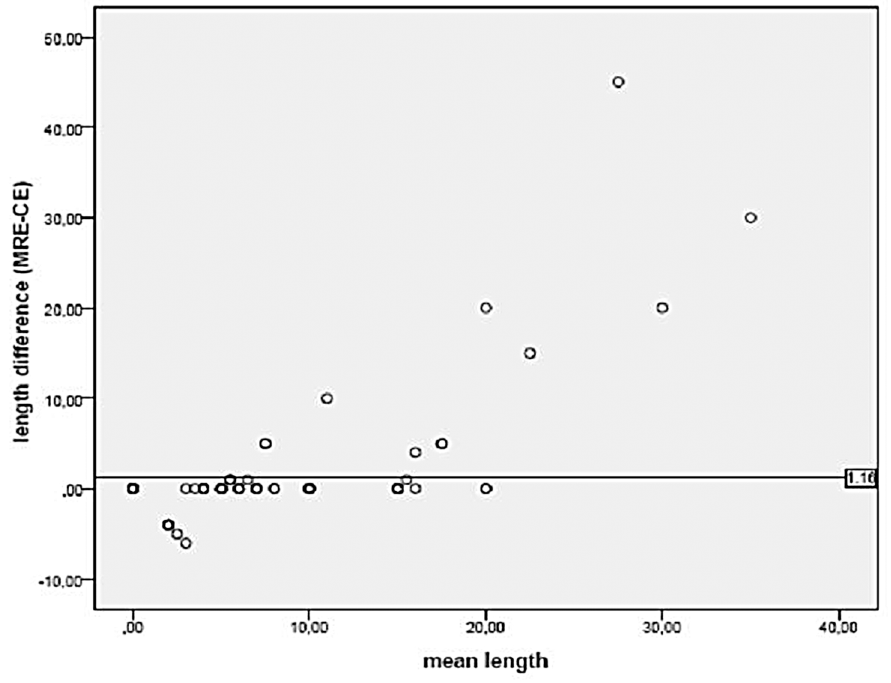
Fig 6. The relation between the mean length and the difference in length of the affected small bowel measured by MR Enterography and Contrast Enhanced